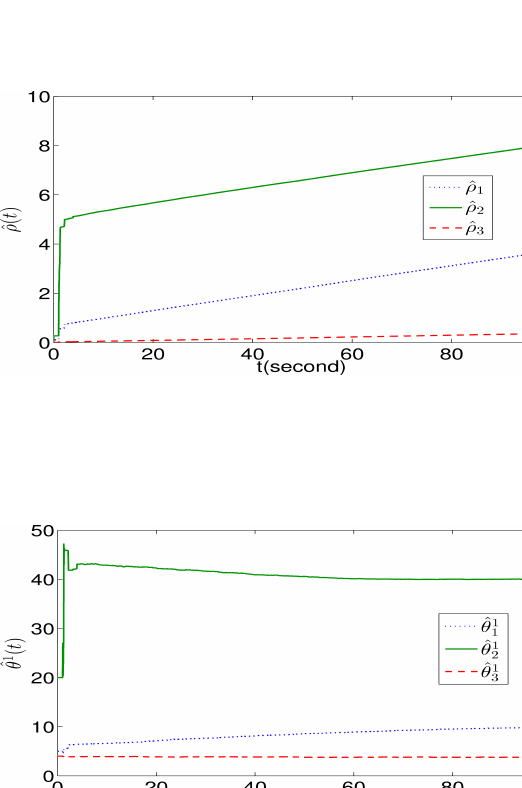
Fig. 3. Time response of